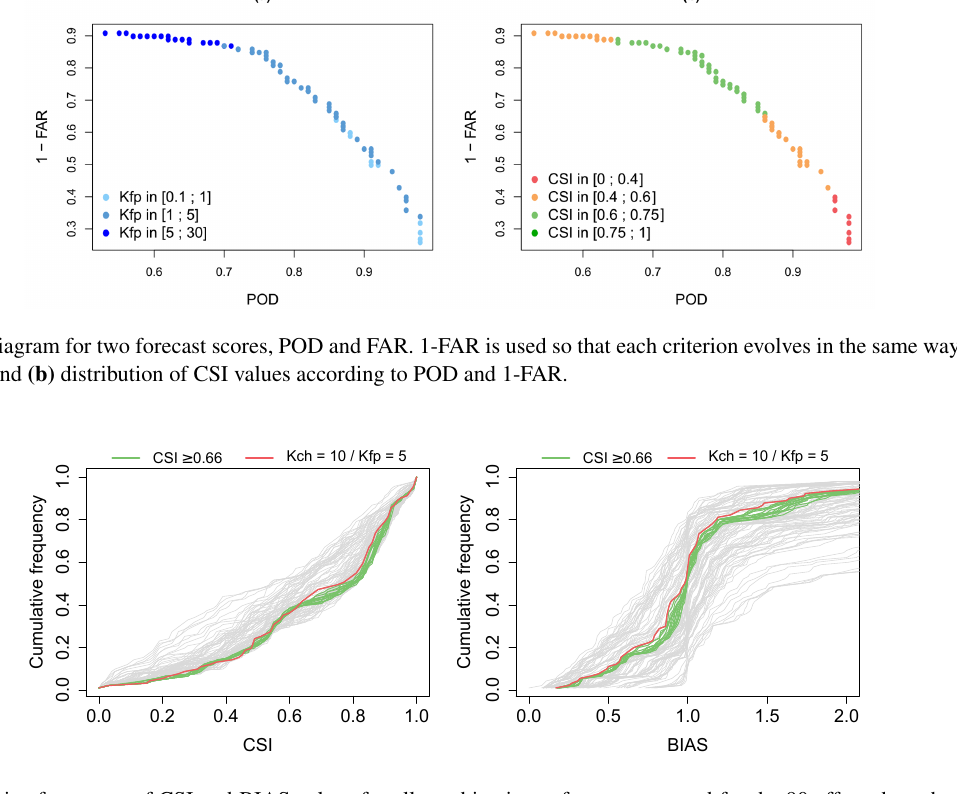
Figure 11. Cumulative frequency of CSI and BIAS values for all combinations of parameters and for the 90 affected reaches. Green lines correspond to the best combinations identified in Fig. 9 while the red line refers to the physical parametrisation. The other parameters are displayed in